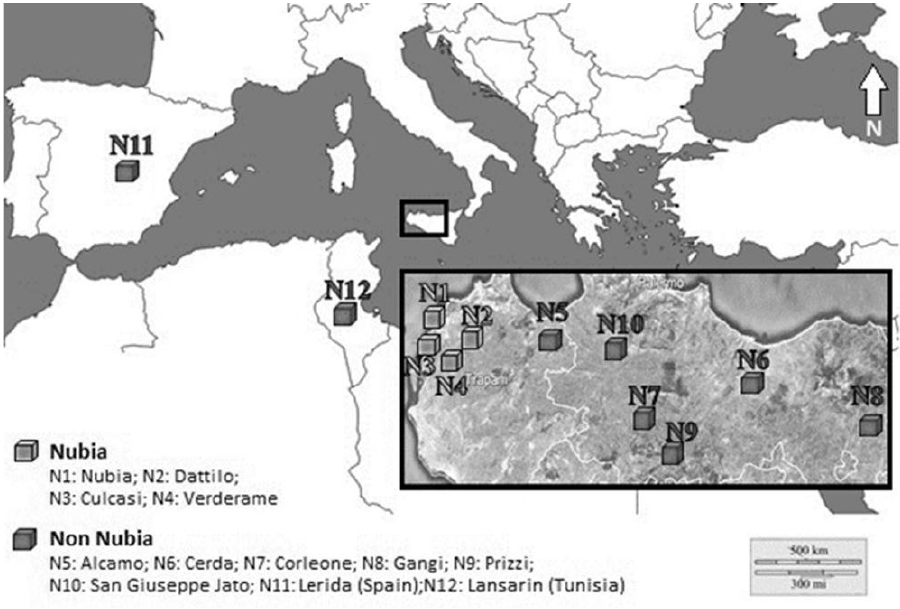
Figure 1. Geographic localization of Nubia and Non Nubia garlic samples.